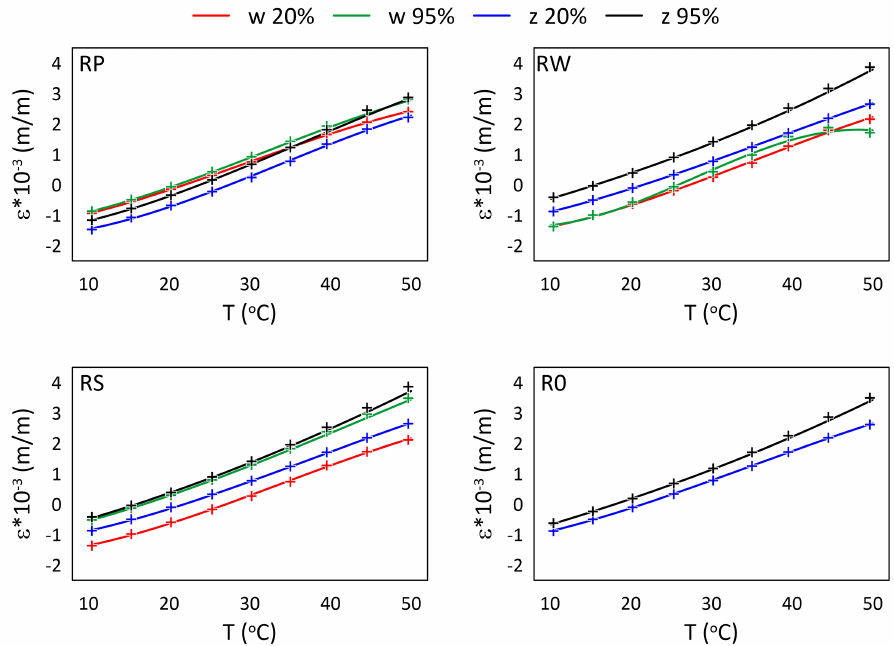
Figure 11. Strain for M3 Crystal samples under elevated temperatures and selected RH (20%, 95%) levels; crosses—measured values, continuous